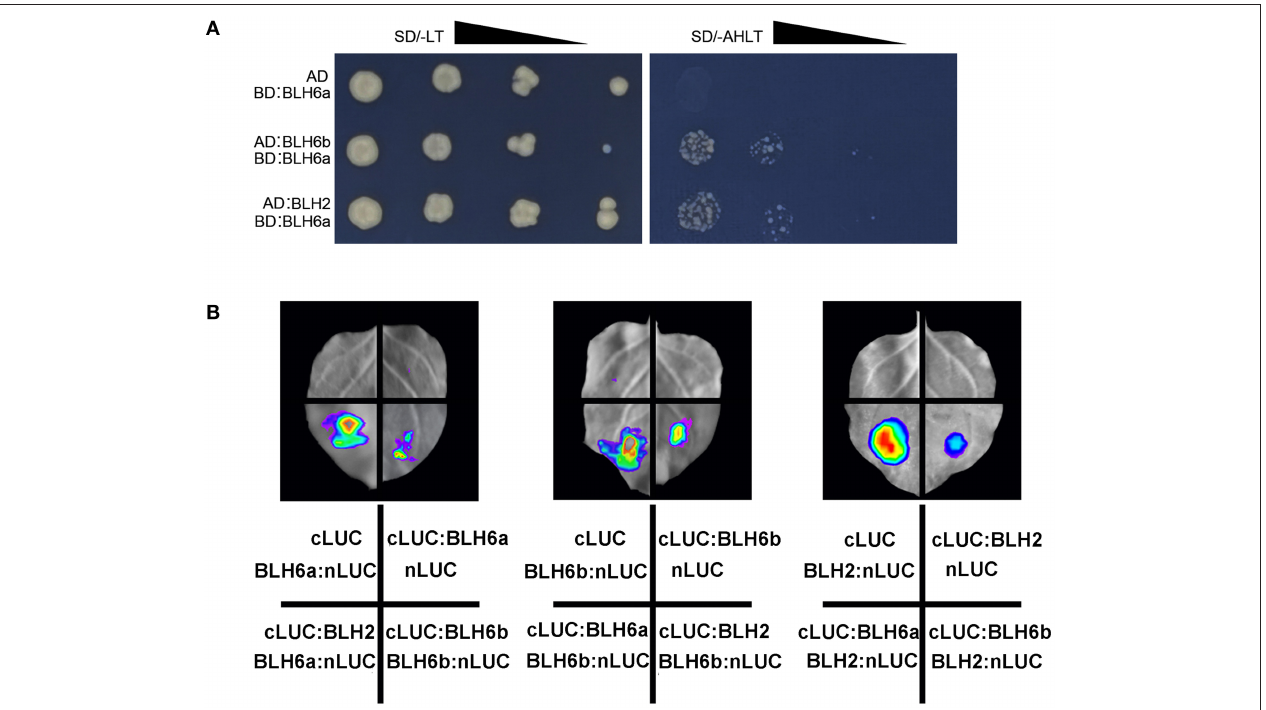
FIGURE 5 | Protein–protein interactions of BLH6a, BLH6b, and BLH2. (A) Yeast two hybridizations. BLH6a was fused with Gal4-binding domain (BD). BLH6b and BLH2 were fused with activation domain (AD). The resulting AD constructs (AD:BLH6b, AD:BLH2) and BD construct (BD:BLH6a) were co-transfected into a yeast cell, grown on the SD/-Leu-Trp medium (SD/-LT), and selected on the SD/-Ade-His-Leu-Trp medium (SD/-AHLT). (B) Luciferase complementation imaging (LCI) assays for the detection of the interactions between two proteins of BLH6a, BLH6b, and BLH, with one of them being fused to the N-terminal portion of LUC (nLUC), and the other being fused to the C-terminal portion of LUC